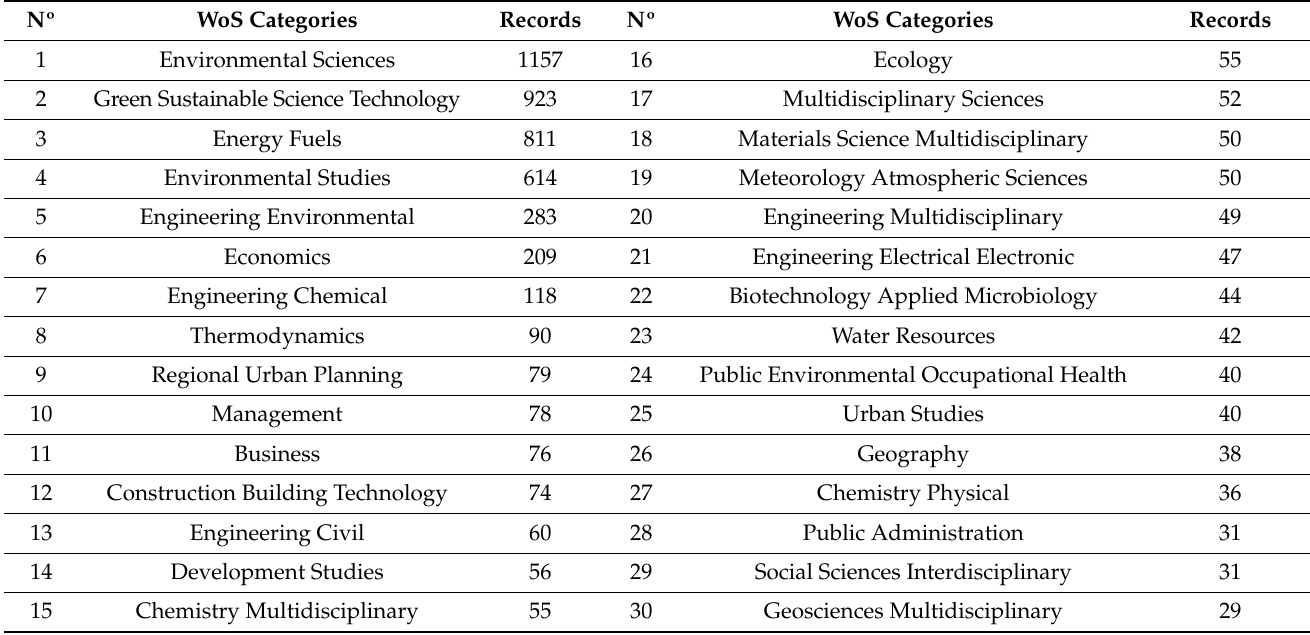
Table 2. Number of results by research fields